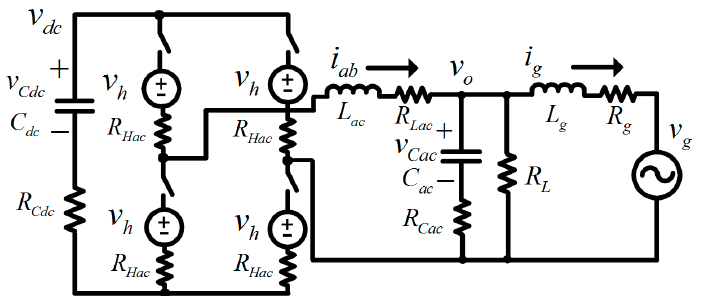
Figure 7. Circuit model for the dc-ac converter.